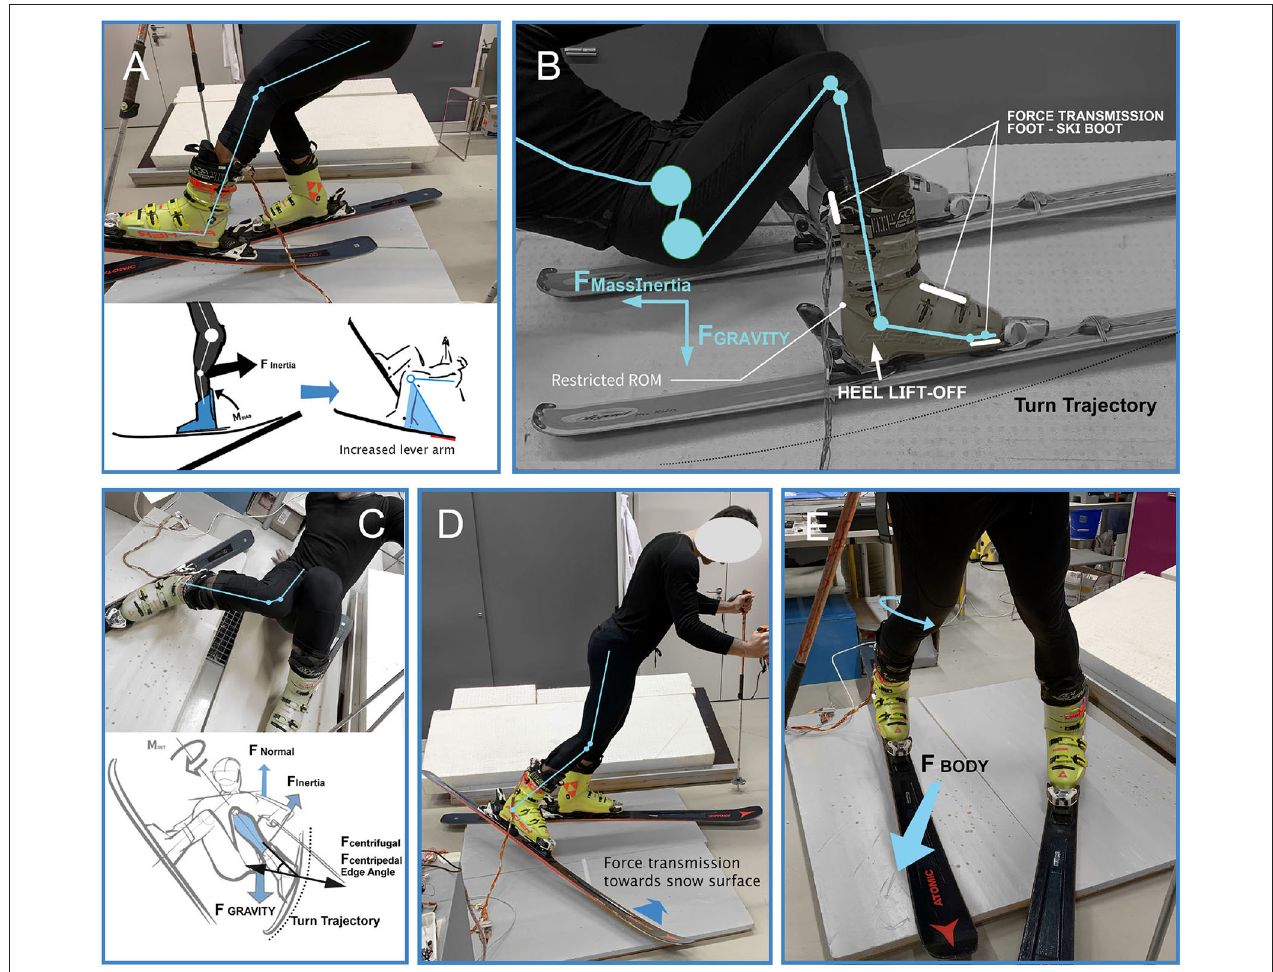
FIGURE 4 | (A) Quasi-statical BIAD force appliance to boot; (B) Skiers’ range of motion influencing the sensor force loading; (C) Phantom Foot: Increasing strain from a low starting position; (D) Inside edge pressure raise (cf. VER); (E) Slip-catch